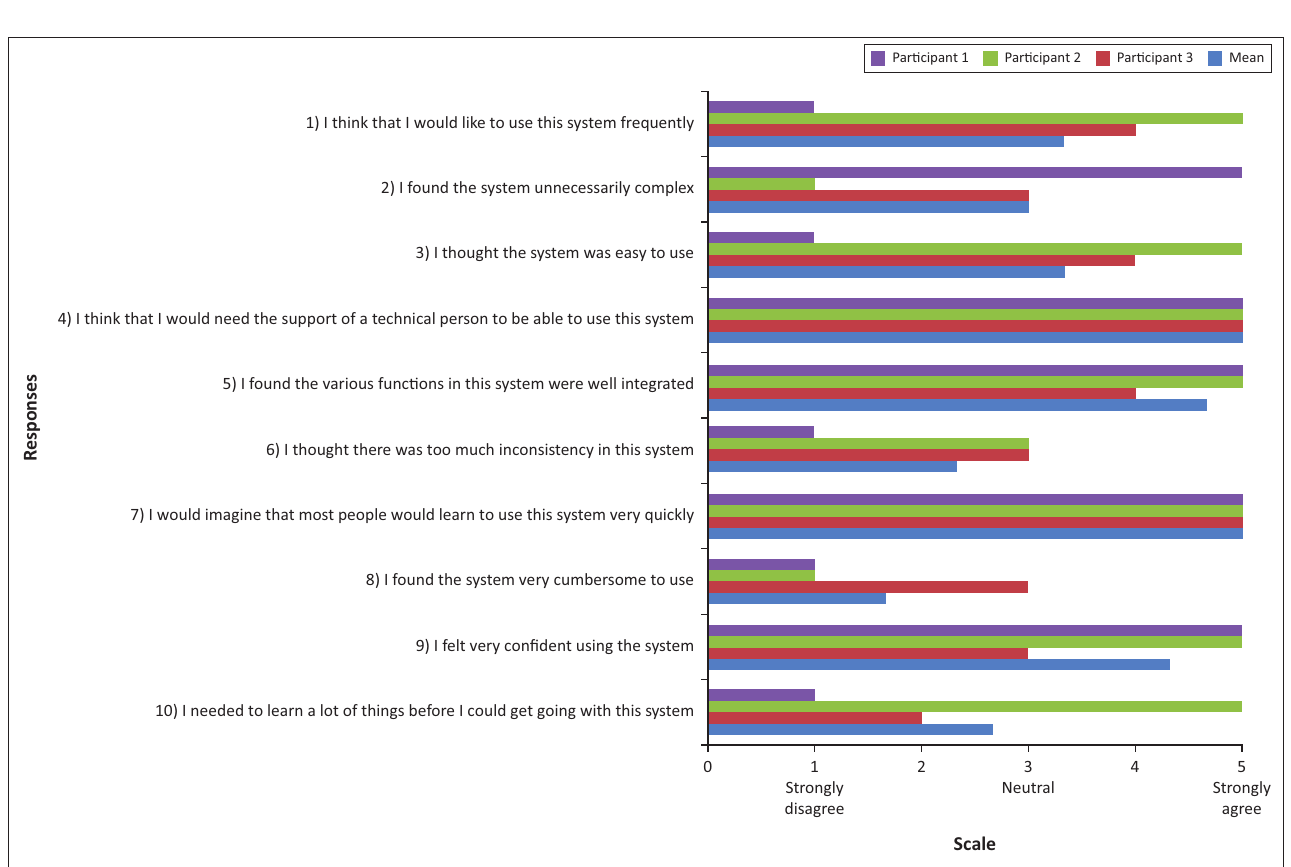
FIGURE 2: System usability scale